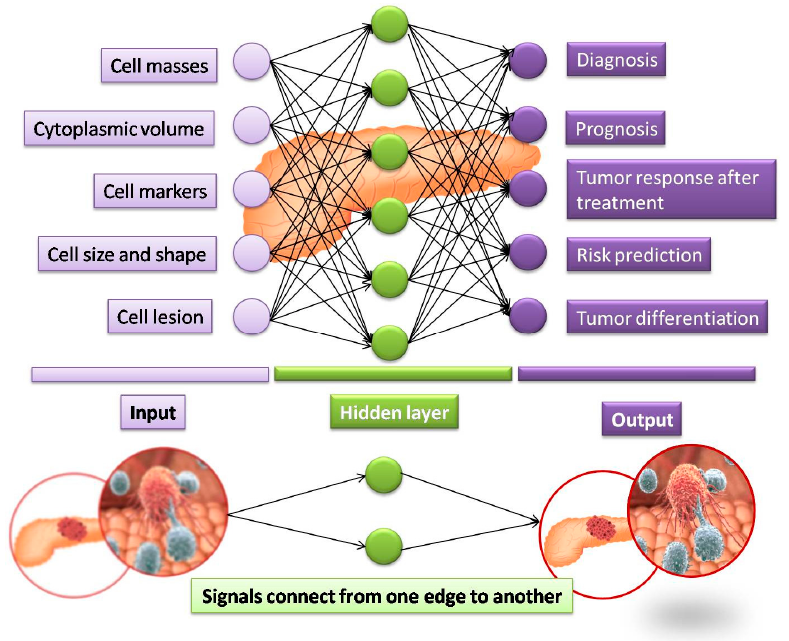
Figure 2. Schematic representation of the process flow in a sample ANN model for the diagnosis of pancreatic cancer.